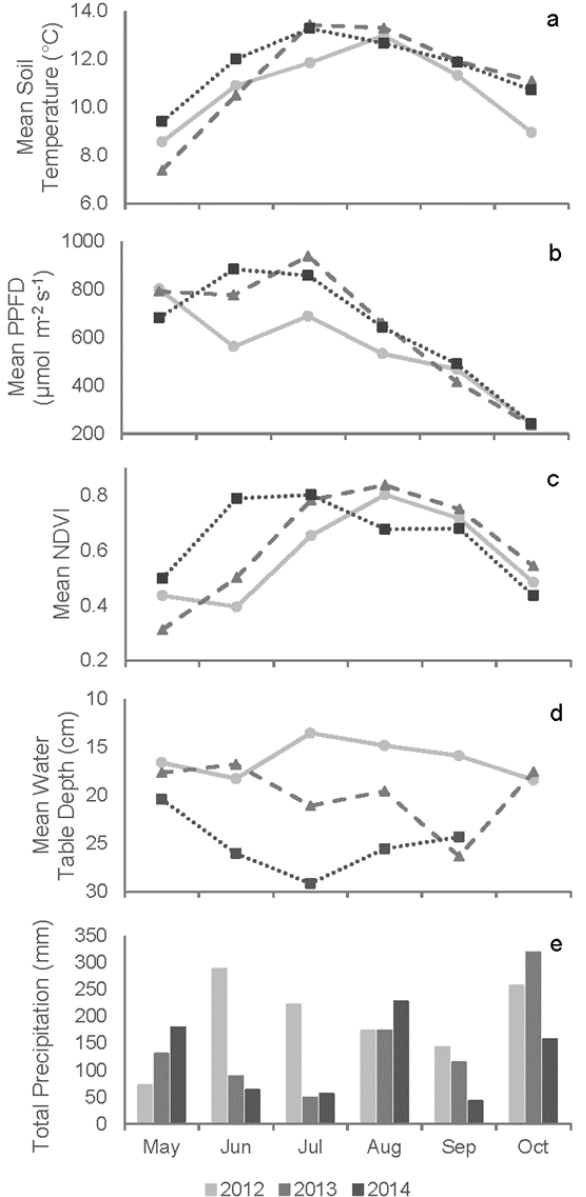
Figure 3. Environmental conditions at Spooners Site S2 in 2012–2014: (a) monthly mean soil temperature (°C); (b) photosynthetically photon flux density (μmol m -2 s -1 ); (c) Normalised Difference Vegetation Index (NDVI); (d) water table depth (cm below surface); (e) precipitation (mm).